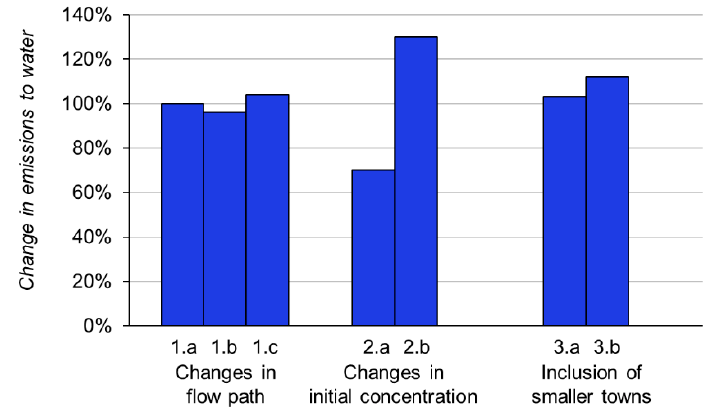
Figure 6. Relative changes in nutrient emissions to water in seven alternative scenarios, compared to the baseline scenario: 1.a increased use of buckets from Copenhagen by farmers; 1.b 50% less pipes; 1.c 50% more pipes; 2.a reduction factor of 50% for present nutrient loads from human and animal